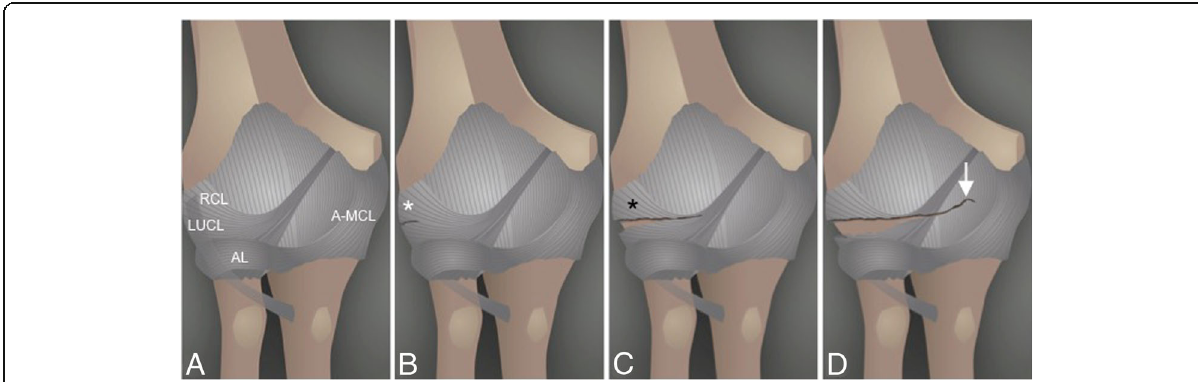
Fig. 22 Anterior view of the elbow demonstrating the progression of the structures injured in a posterior dislocation, from lateral to medial. a Normal. b Proximal disruption of the lateral ulnar collateral ligament (white asterisk). c Proximal disruption of the lateral ulnar collateral ligament and the radial collateral ligament (black asterisk). d Anterior capsule tear (white arrow). Lateral ulnar collateral ligament (LUCL). Radial collateral ligament (RCL). Annular ligament (AL). Anterior bundle of the medial collateral ligament complex (A-MCL)